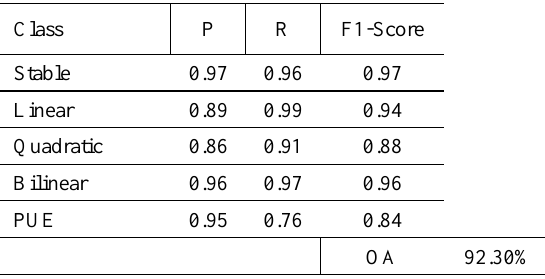
Table 2 . The CNN classifier performance.